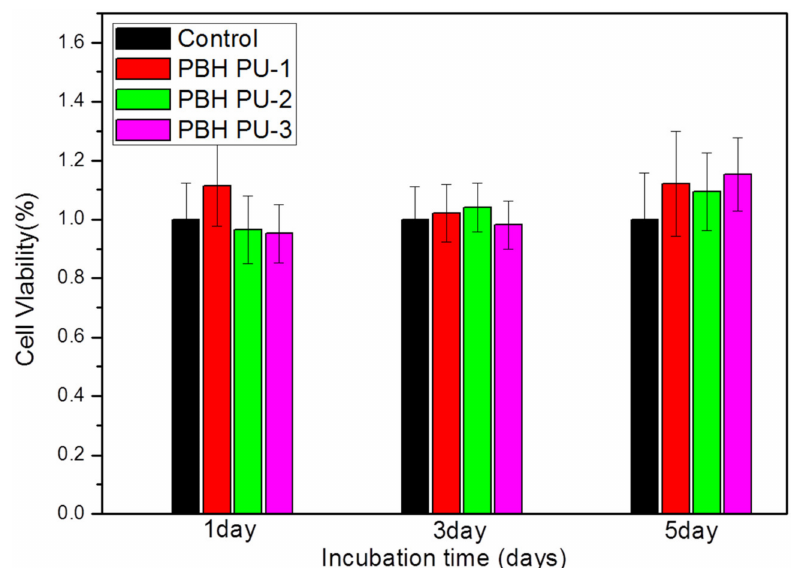
Figure 10. MTT assay of hBMSCs cultured on polyurethanes.